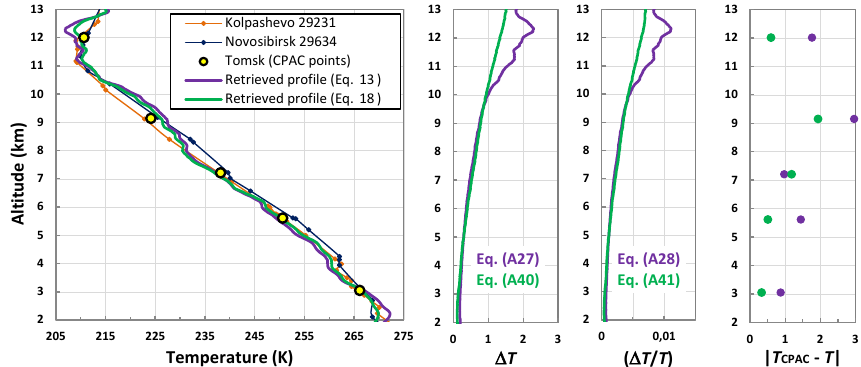
Figure 13. (2 October 2014) Temperature profiles retrieved using Eqs. (13) and (18).